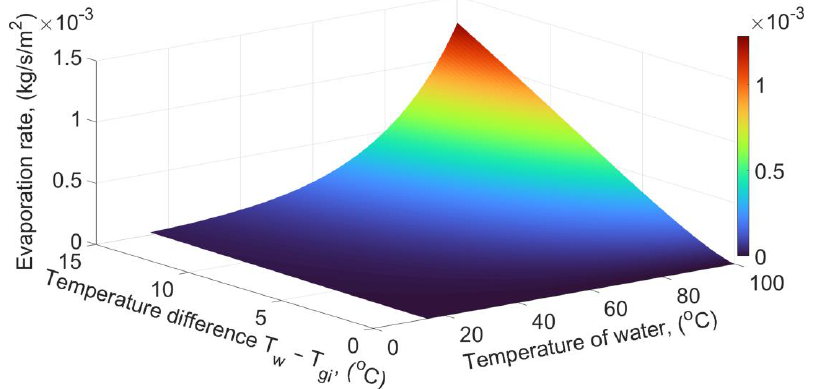
Figure 10. Water-evaporation rate in the function of the water temperature and the temperature difference between water and glass cover. Table 7. The evaporation rate of water (mg/s/m 2 ) in the function of the temperature of the water and the temperature difference between water and cover. T w , (°C)